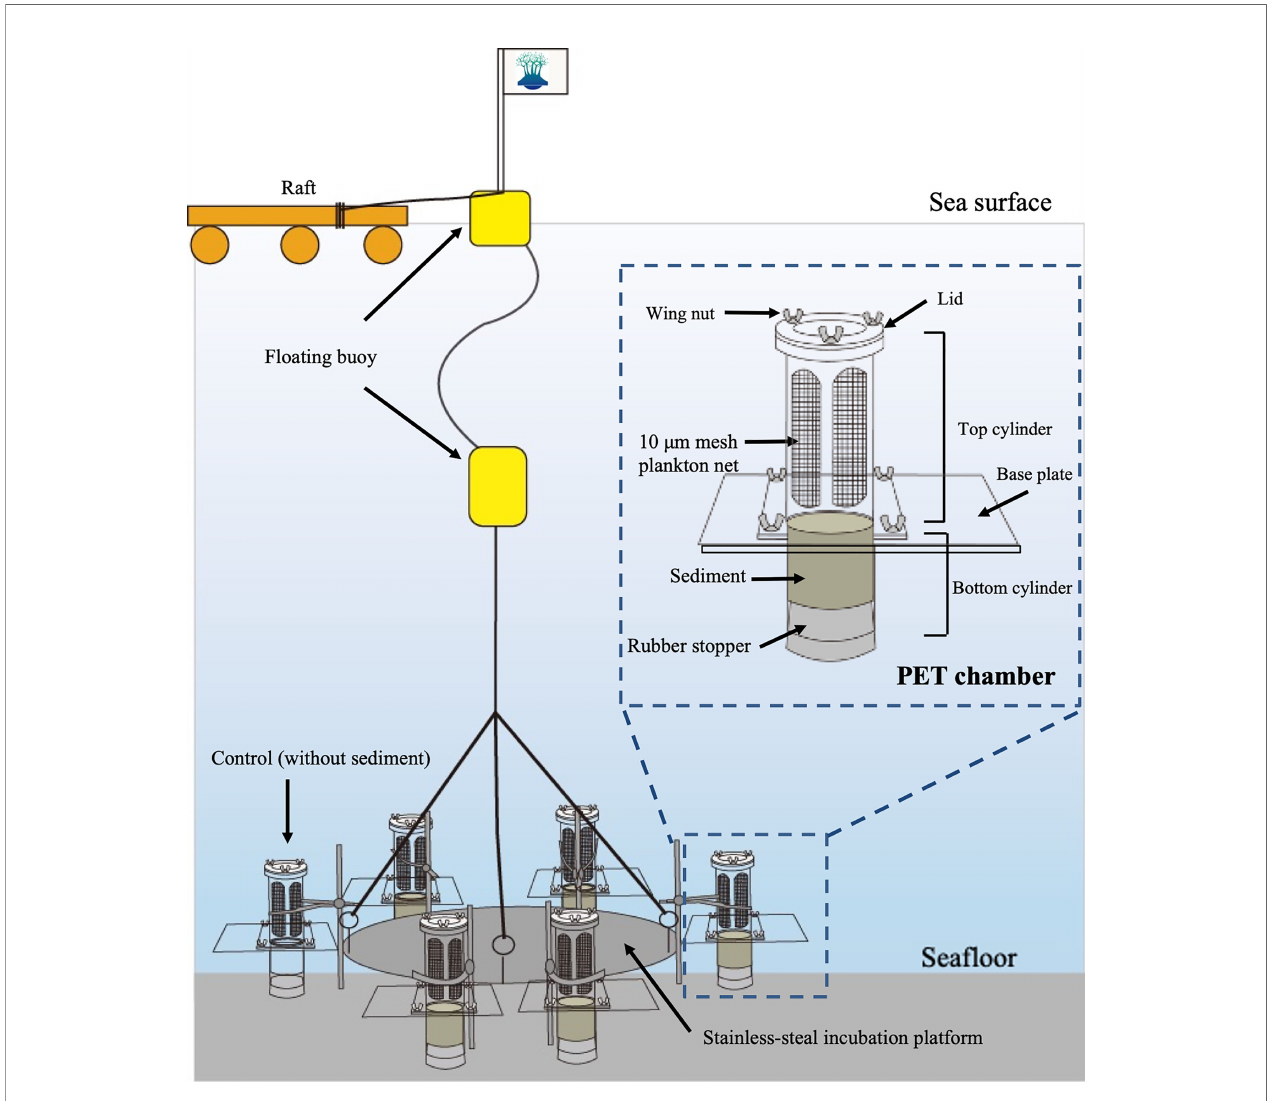
FIGURE 3 | Schematic diagram showing plankton emergence trap/chamber (PET chamber)